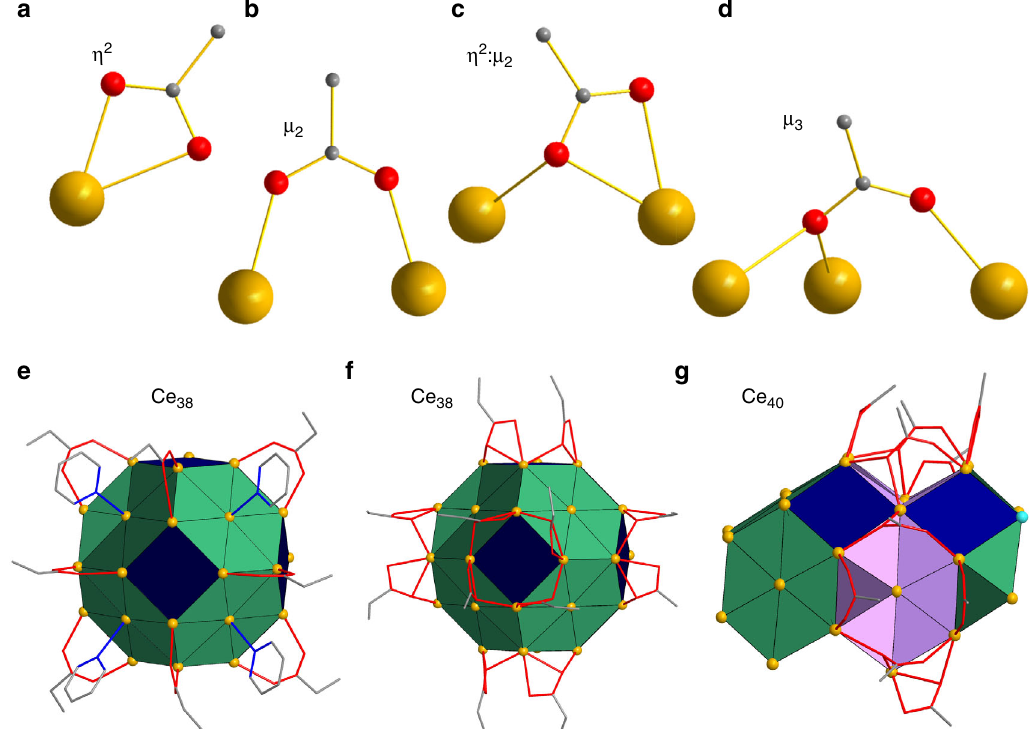
Fig. 2 Ligand binding modes on the surface of ceria nanoclusters. The different binding modes of surface carboxylate and pyridine groups in 1 – 3 : a chelating ( η 2 ); b µ 2 -bridging; c η 2 -chelating and µ 2 -bridging; d µ 3 -bridging; e Ce 38 ( 2 ) showing terminal pyridines ‘ capping ’ (binding to the center of) the (111) hexagons, and µ 2 -carboxylates bridging edges joining two (111) facets; f Ce 38 ( 2 ) showing η 2 : μ 2 -carboxylates at edges joining (100) and (111) facets; and g Ce 40 ( 3 ) showing η 2 : μ 2 - and μ 3 -carboxylates on edges of (110) facets, and µ 2 -carboxylates bridging edges joining (110) and (111) facets. Colour code: Ce IV gold, Ce III sky-blue, O red, N blue, C grey, (100) facets dark blue; (110) facets violet; (111) facets